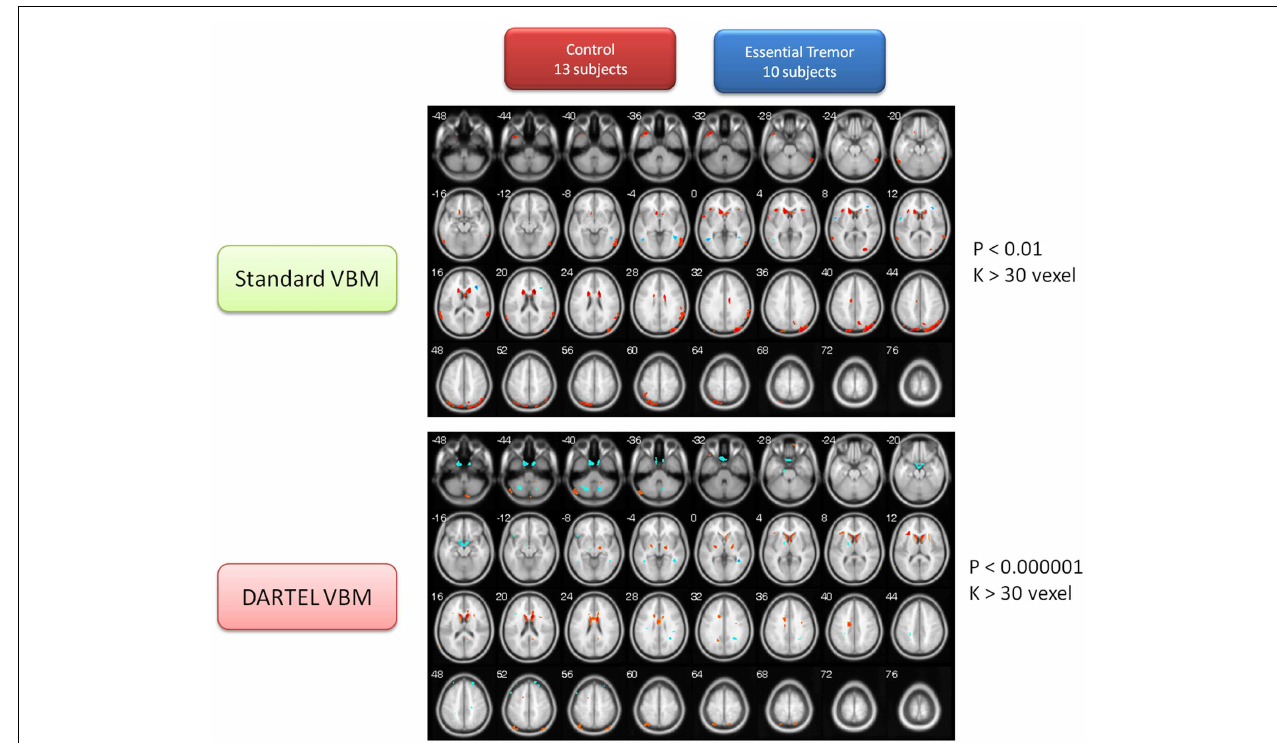
temporal cortex, and parietal cortex were also observed. On the other hand, the DARTELVBM method also confirmed that the caudate nucleus serious atrophy in ET patients. Additionally, the parietal cortex, cerebellum, and thalamus atrophy in ET patients was observed in DARTELVBM method. Conversely, the two methods congruently identified that the bilateral MTG was significantly large than that of normal